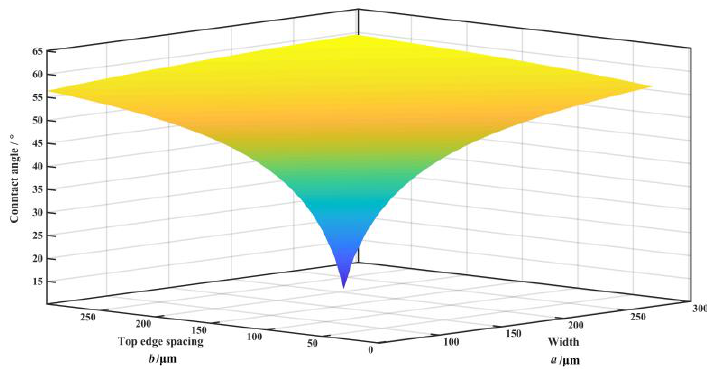
Figure 4. Three-dimension curve of contact angle and structural parameter under complete wetting prediction model.